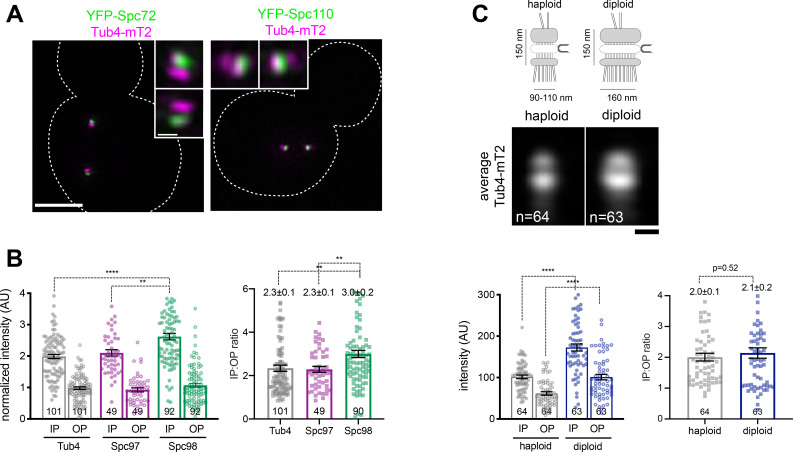
Quantitative detection of γTC by SIM shows SPB size scaling and roles for the outer plaque.(A) SIM images of cells containing Tub4-mT2 (magenta) and YFP-Spc72 or YFP-Spc110 (green), which mark the SPB outer and inner plaque, respectively. Insets show SPB region. Bar, 2 µm and 200 nm (inset). (B) SIM images of strains containing Spc110-YFP and the indicated γTC component fused to mT2 were analyzed by fitting spots corresponding to the inner and outer plaques. Each individual value is plotted along with the mean, standard error and number of SPBs analyzed (n). Ratios were derived from intensity measurements. (C) Schematic showing the inner, central and outer plaques of the SPB along with the half-bridge. The average width and height based on EM measurements of haploid and diploid cells is shown (Adams and Kilmartin, 1999; Byers and Goetsch, 1974). Haploid and diploid cells containing Tub4-mT2 were imaged by SIM and analyzed as in (B). In addition, an average image was also created. n, number of cells. ****, p<0.0001; **, p<0.01. Note that in both (B) and (C), there is heterogeneity within individual SPBs at both the inner and outer plaque. Importantly, SIM was able to detect quantitative differences in inner and outer plaque intensity that scaled proportionally with SPB size, indicating that it can be used to assay changes at the SPB.